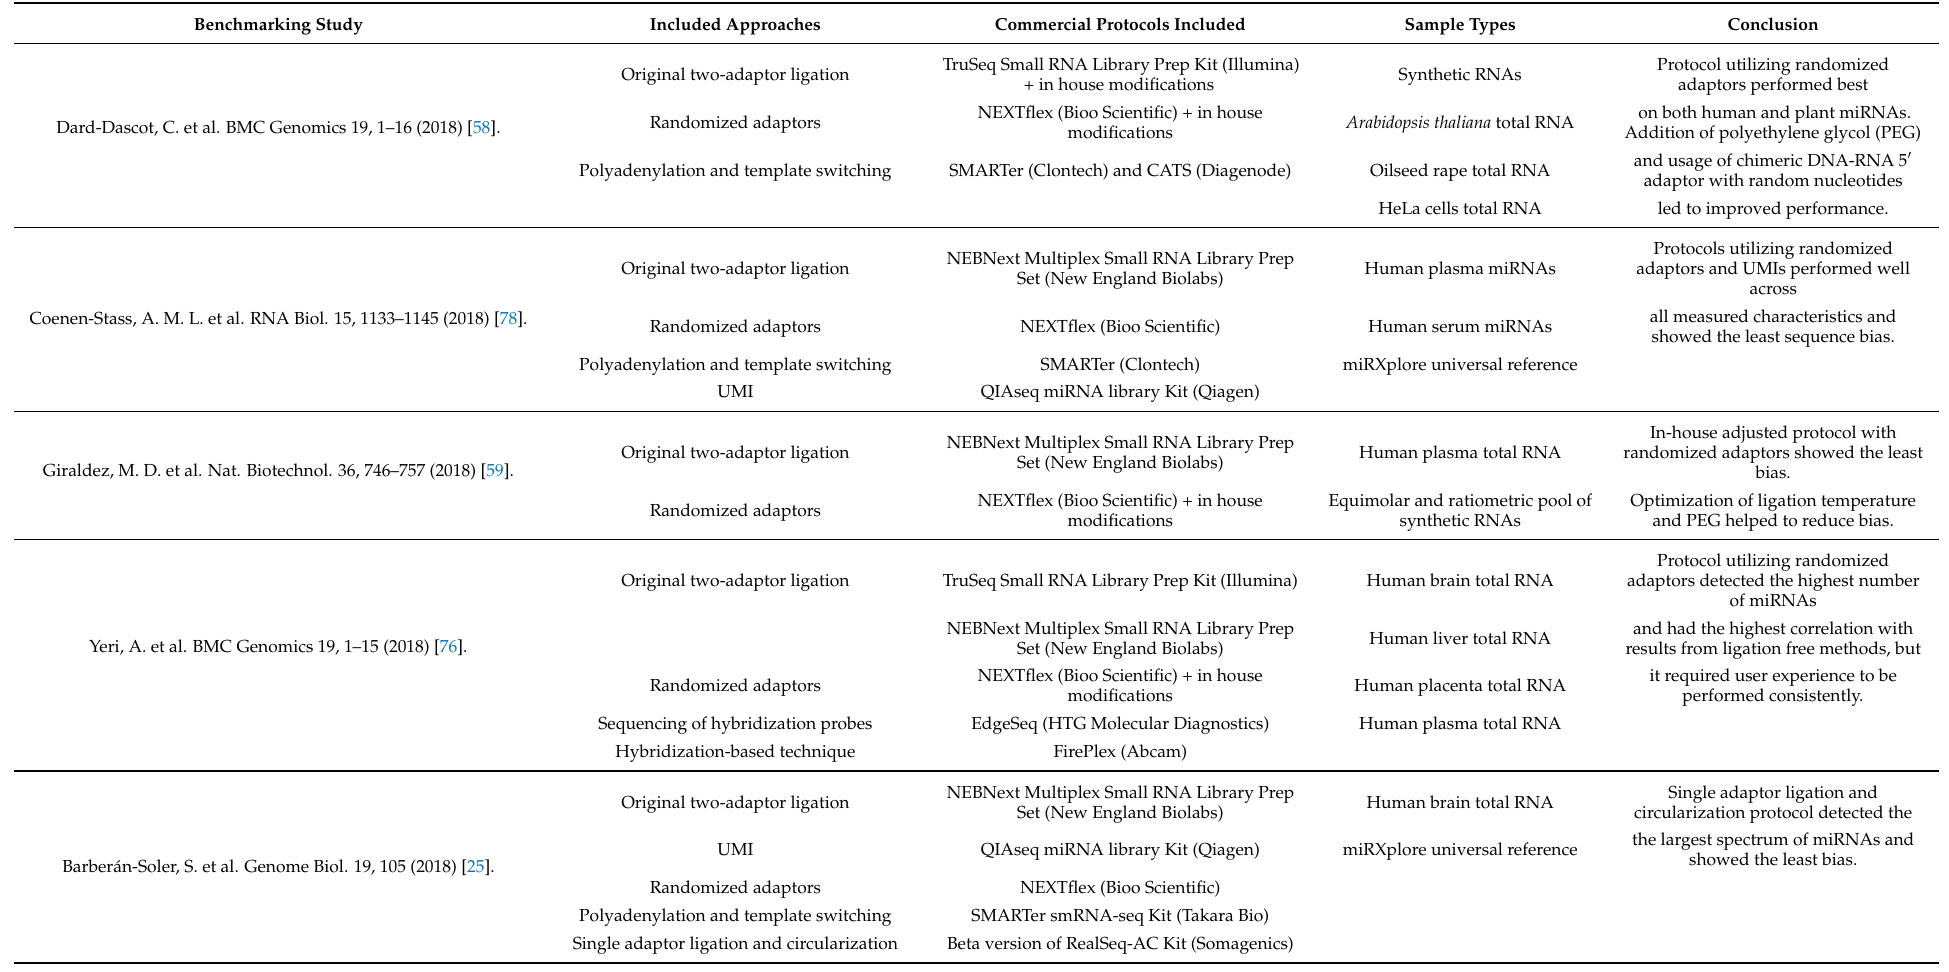
Table 2. Overview of recently published benchmarking studies of small RNA-seq protocols. Some protocols were benchmarked when offered by different companies, therefore, the names may vary from the Table